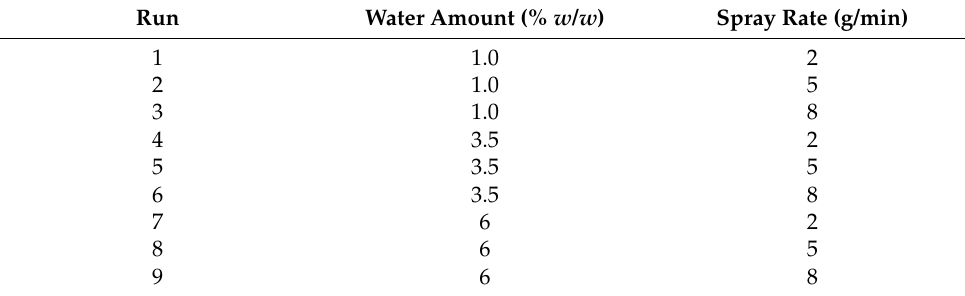
Table 2. A 3 2 full-factorial experimental